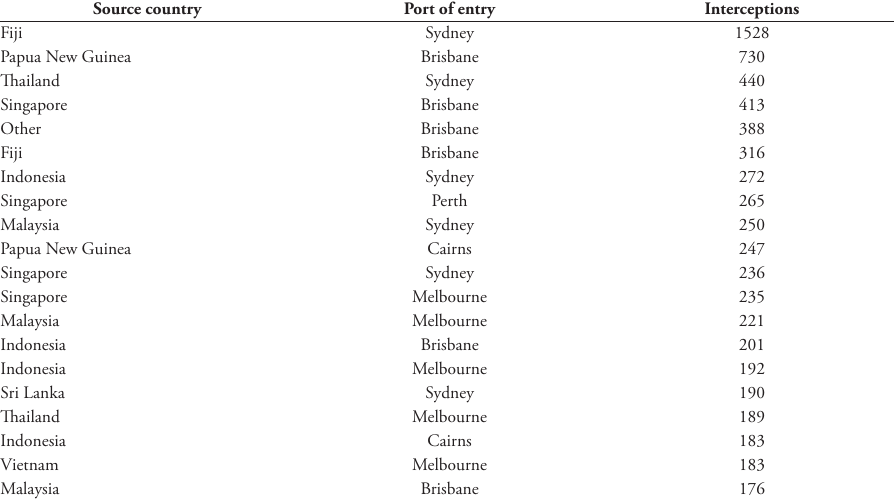
Table 1. Top 20 pathways for commerce on which ants were intercepted in Australia from 1986–2010. From a total of 14140 records, these top eight source countries account for approximately 48% of